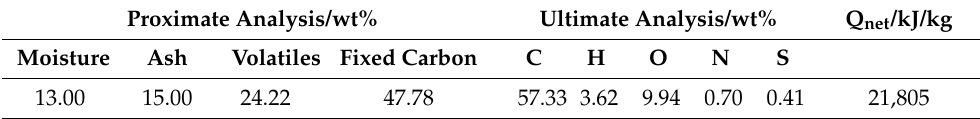
Table 1. Fired coal properties. Proximate Analysis/wt%